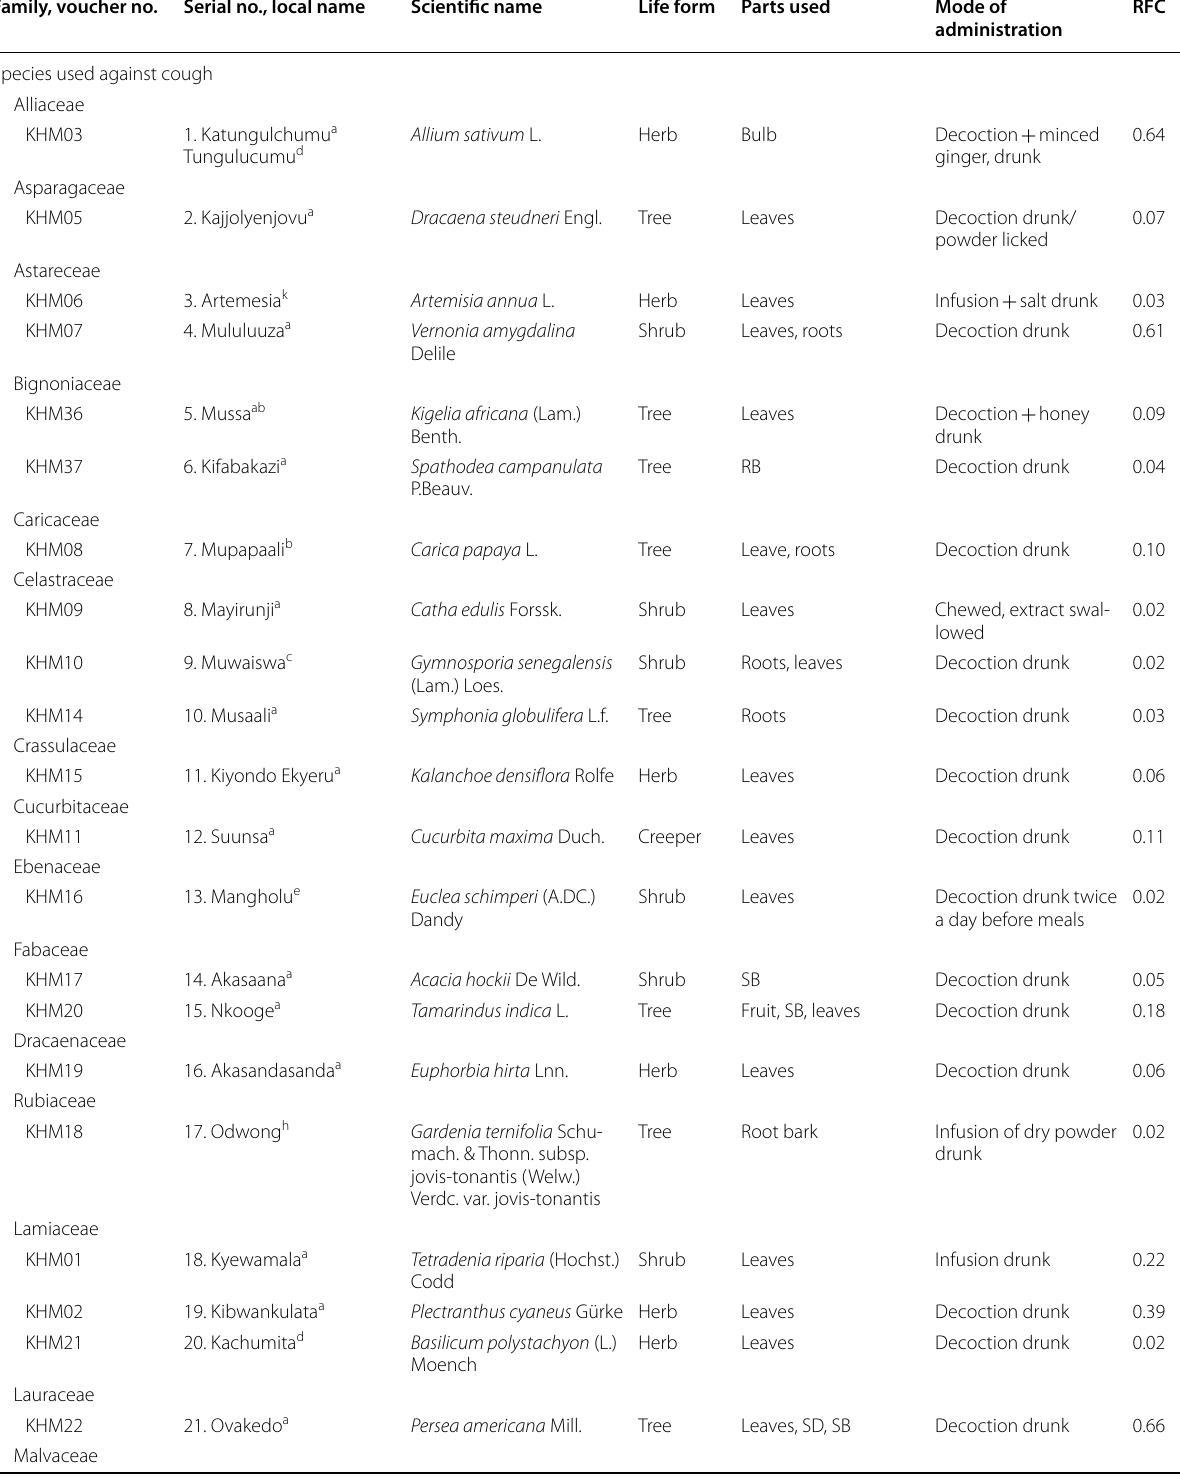
Table 2 Medicinal plants used for treatment of diarrhea and cough in Kampala city, Uganda Family, voucher